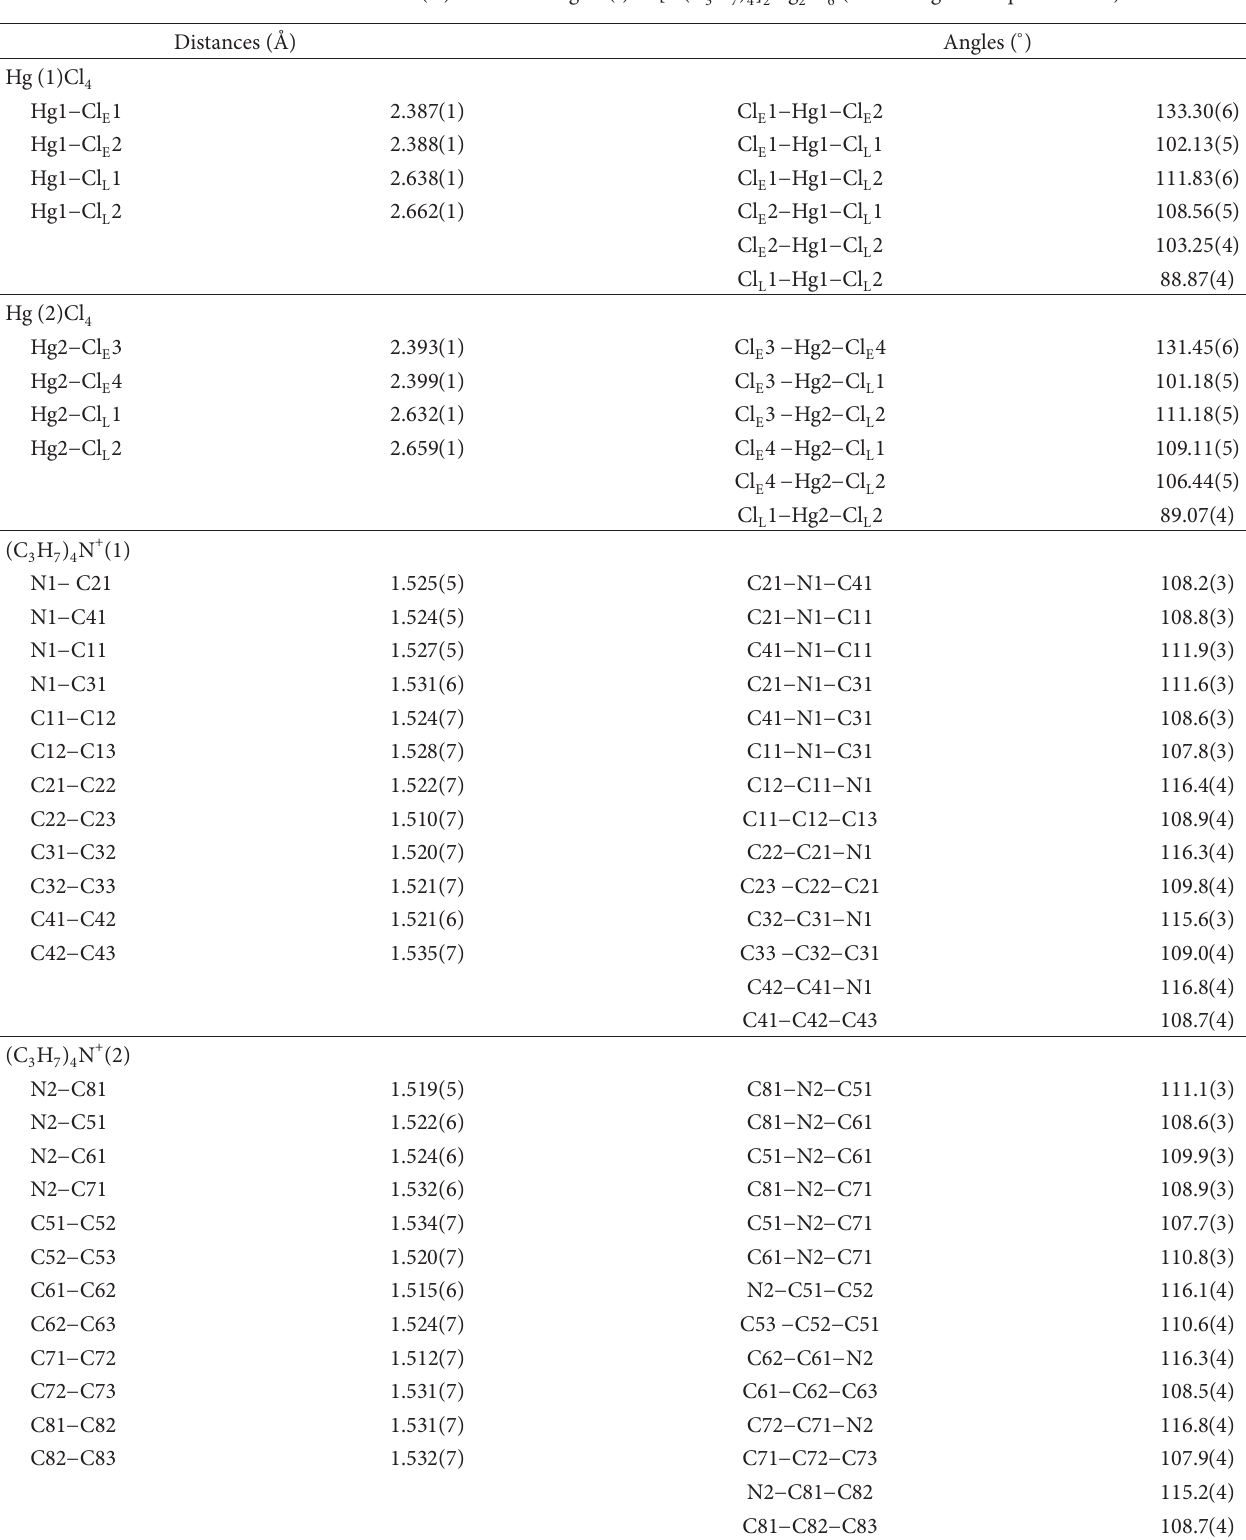
T 2: Selected bond distances (Å) and bond angles